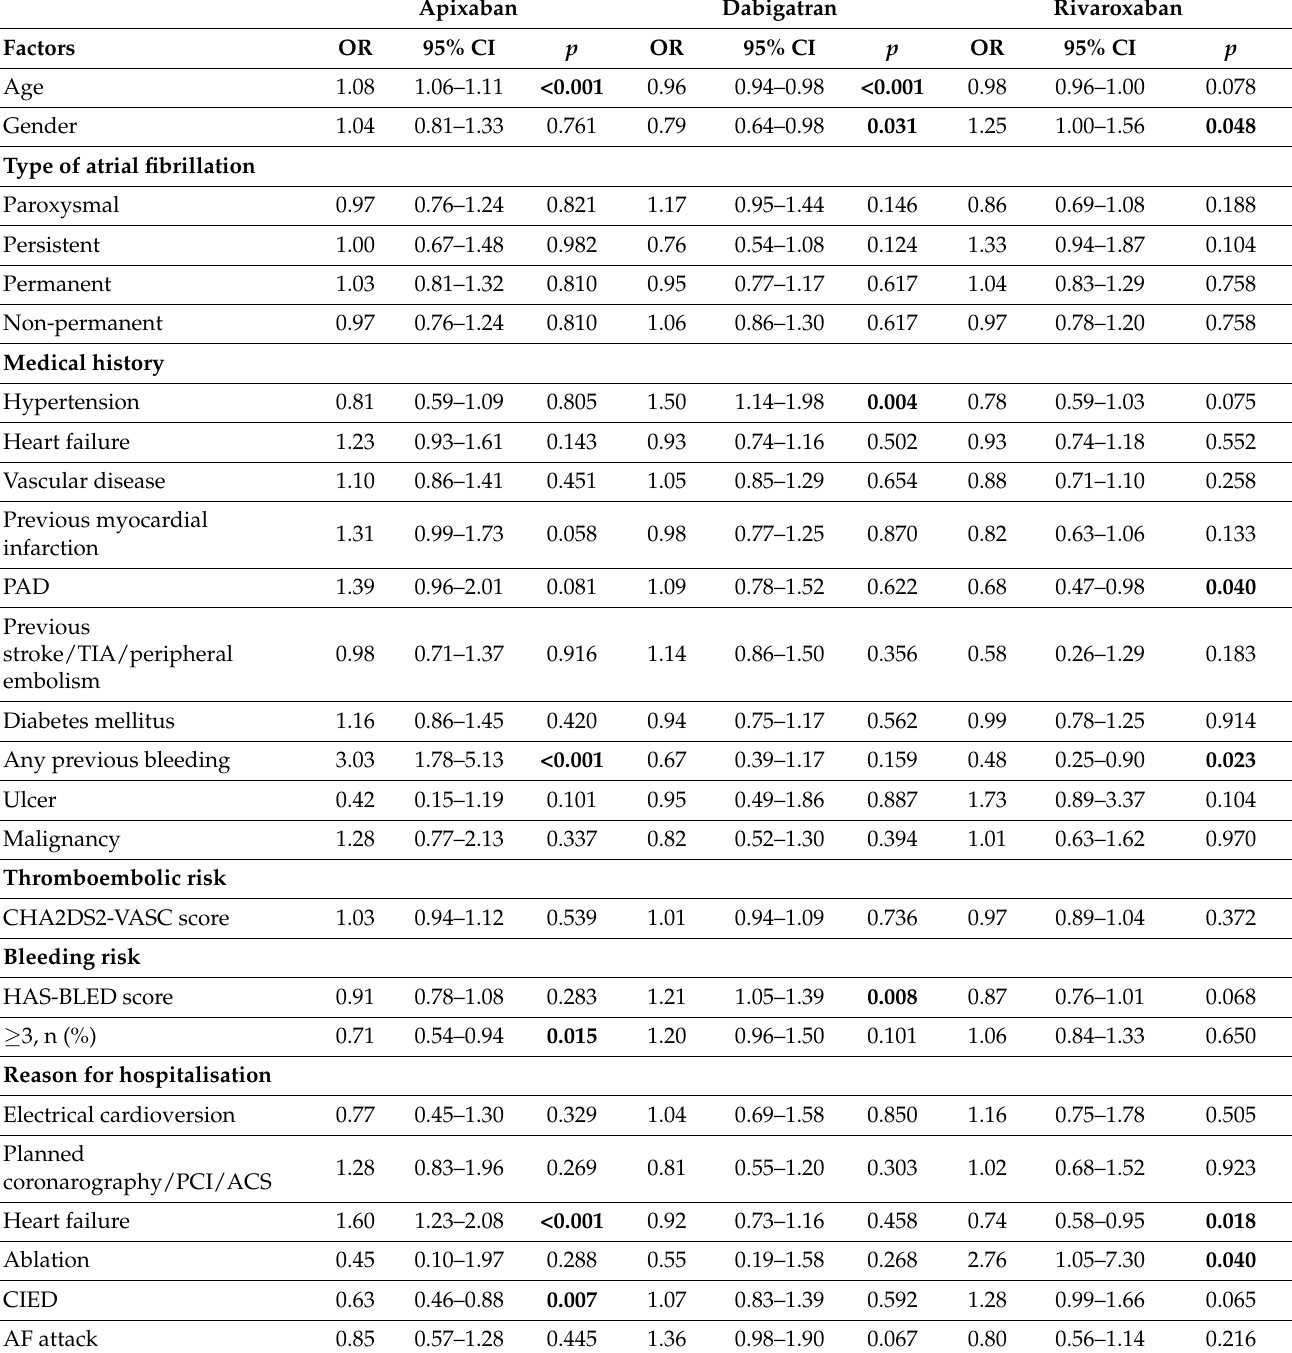
Table 2. Results of univariate regression analyses for the use of apixaban, dabigatran and rivaroxaban,